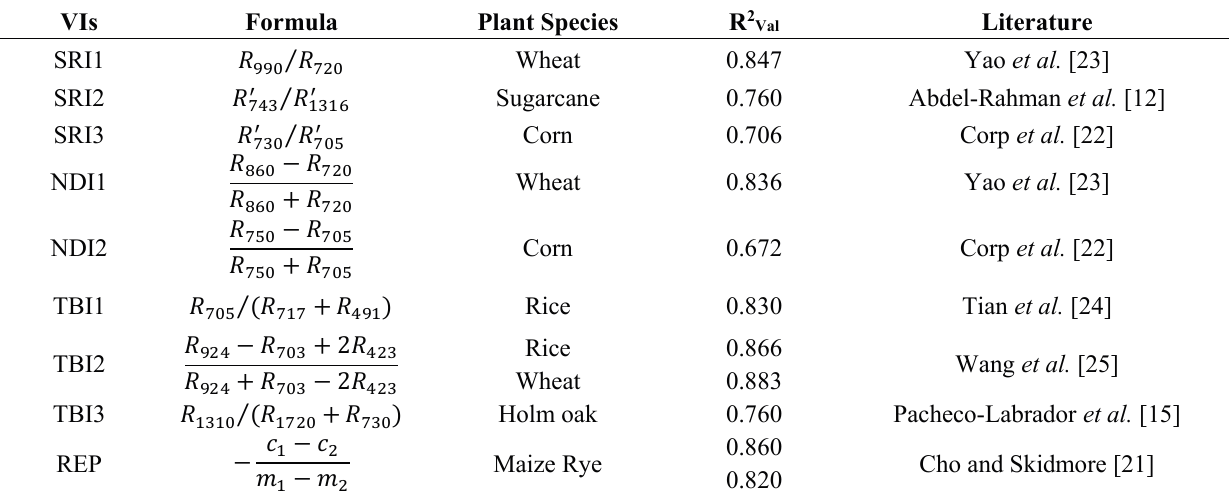
Table 1. Nine published vegetation indices (VIs) for N or N-related component estimation using canopy hyperspectral reflectance. SRI, simple ratio index; NDI, normalized difference index; TBI, three-band